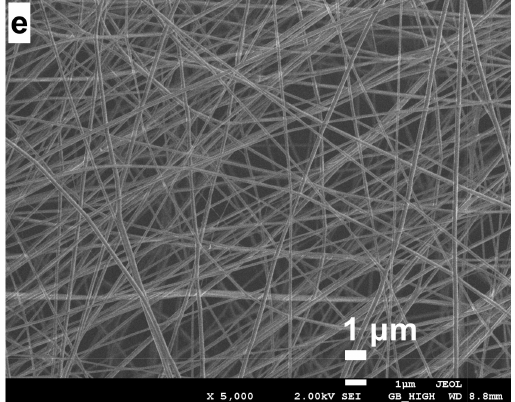
Figure 5. SEM characterization of electrospun nanofibers on a RVC support at different times: ( a ) 15; ( b ) 30; ( c ) 60; ( d ) 90; and ( e ) 120 min.